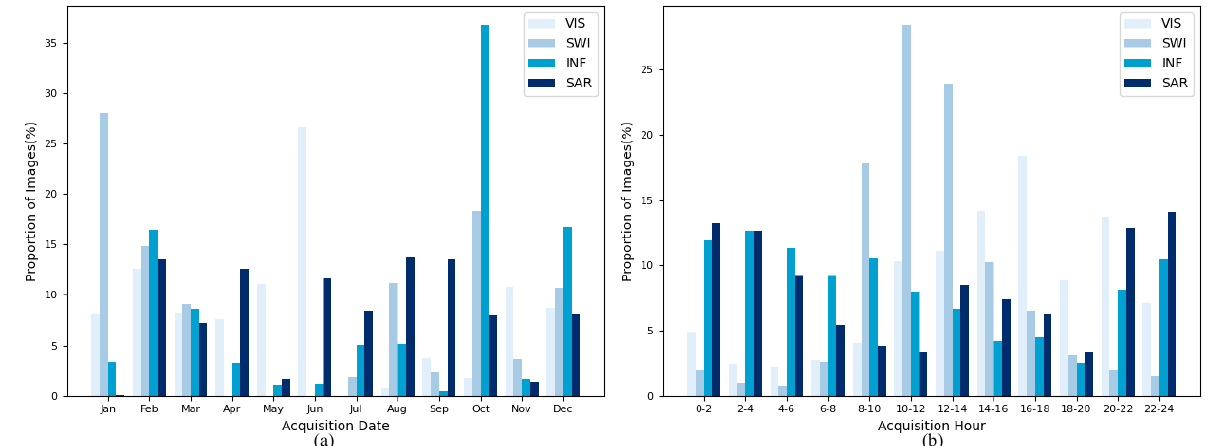
Figure 2. Proportion of MRSSC2.0 images on ( a ) acquisition date, ( b ) acquisition hour.